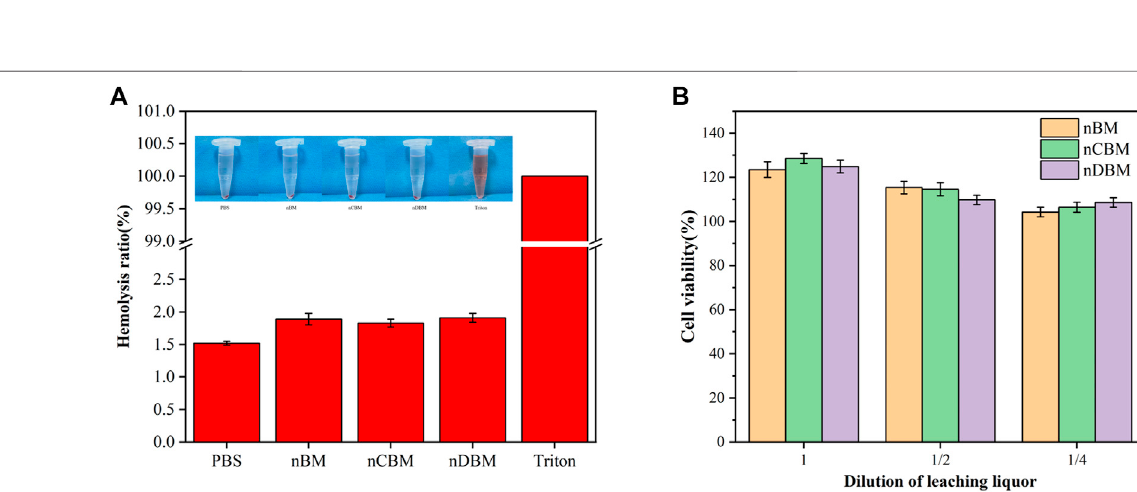
Frontiers in Bioengineering and Biotechnology |